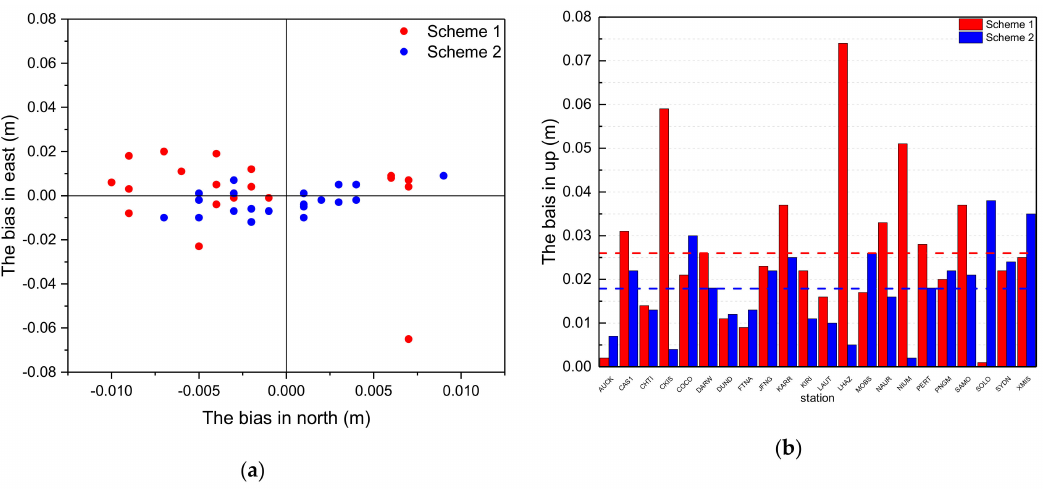
Figure 11. Coordinate bias of precise point positioning (PPP) by using estimated orbits of GPS and BeiDou from schemes 1 and 2: ( a ) bias in the north and east (NE) directions; ( b ) bias in the up direction. In Figure 11a, the red points indicate the bias distribution in the north and east (NE) directions of PPP using the estimated orbits of scheme 1 and the blue points indicate the bias distribution in the NE directions using the estimated orbits of scheme 2. From the results in Figure 11a, the blue points are more concentrated than the red points, which means that the positioning accuracy using the estimated orbits is higher according to scheme 2 than scheme 1. From the results in Figure 11b, the red columns represent bias in the up (U) direction according to scheme 1 and the average value is denoted by the dotted red line. The blue columns are bias in the up direction according to scheme 2, and the average value is denoted by the dotted blue line. The biases of coordinates calculated by PPP for each station are shown in Table 2. Table 2. Biases of coordinates calculated by PPP for each station (unit: